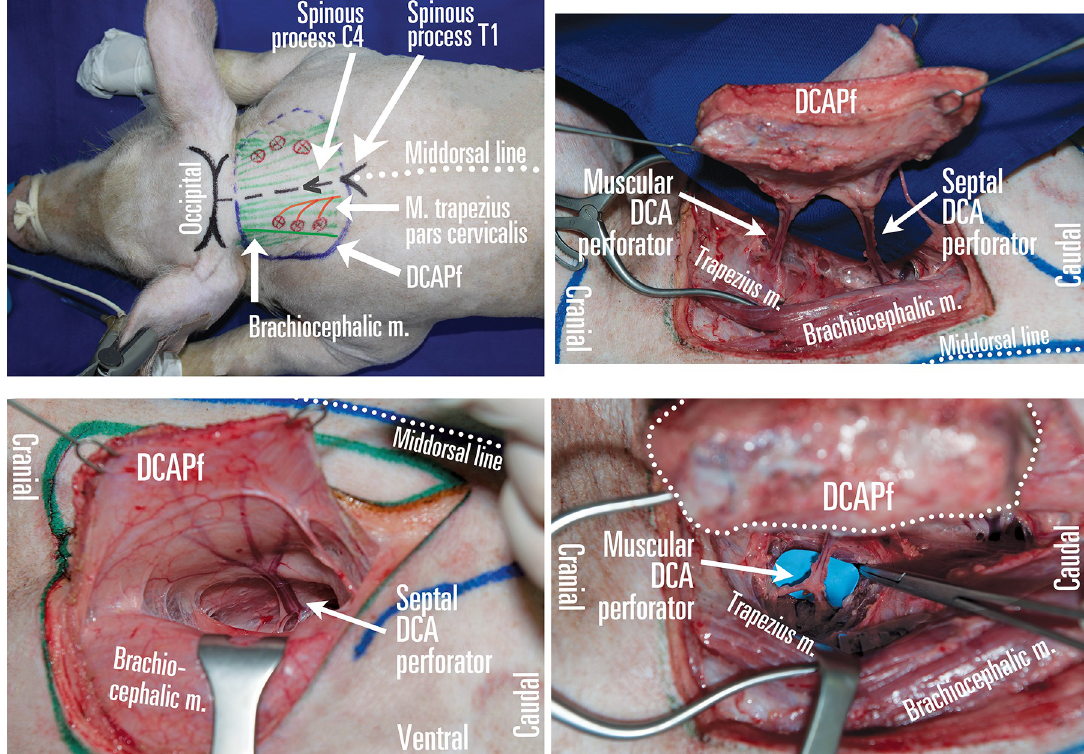
Fig 4. Deep cranial artery perforator flap (DCAPf) planning in pigs. (A) The DCAPf can be designed either as a half-flap, allowing two surgeons to work simultaneously, or as a single extended flap based on one or multiple perforators, which can be either musculocutanous, septocutaneous or both. The spinous process of C4 and T1 vertebrae serve as bony landmarks for flap planning. (B) Dissecting from the lateral margin of the flap over the brachiocephalic and trapezius m., the septocutaneous perforators are uncovered first, which arise from the DCA. (C) The flap paddle can be vascularized by either muscular or septal DCA perforators, or both. (D) Dissection of the muscular perforator leads to exposure of the deep cranial artery. Republished from personal archive under a CC BY license, with permission from Dr. Nistor Alexandru, original copyright 2016. https://doi.org/10.1371/journal.pone.0266873.g004 pulsation time between 5 th and 6 th experimental animal, indicating that even 6 one-day ses- sions of experimental surgery on pigs can lead to a dramatic increase in perforator flap dissec- tion quality.